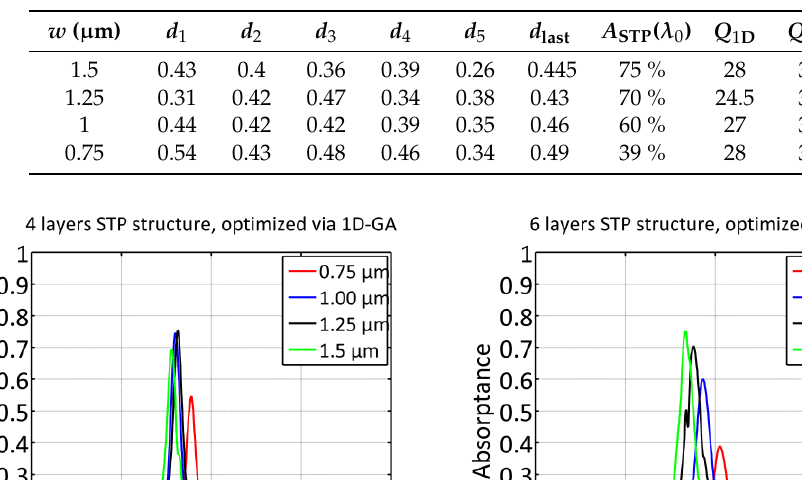
Table 2. Configurations featuring six dielectric layers, analogous to Table 1